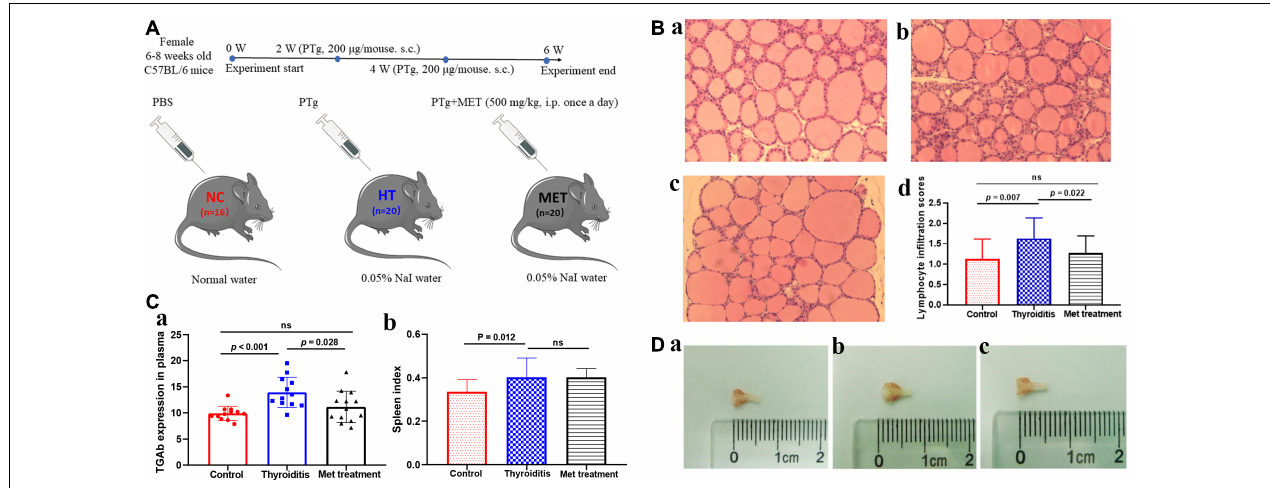
FIGURE 1 | (A) Animal model experiment process. (B) H&E staining of thyroid tissue, (a) control, (b) Thyroiditis, (c) Metformin treated, (d) lymphocyte infiltration scores (ns, not significant). (C) TGAb expression in plasma and spleen index comparison. (D) Mouse thyroid tissue, (a) control, (b) Thyroiditis, (c) Metformin